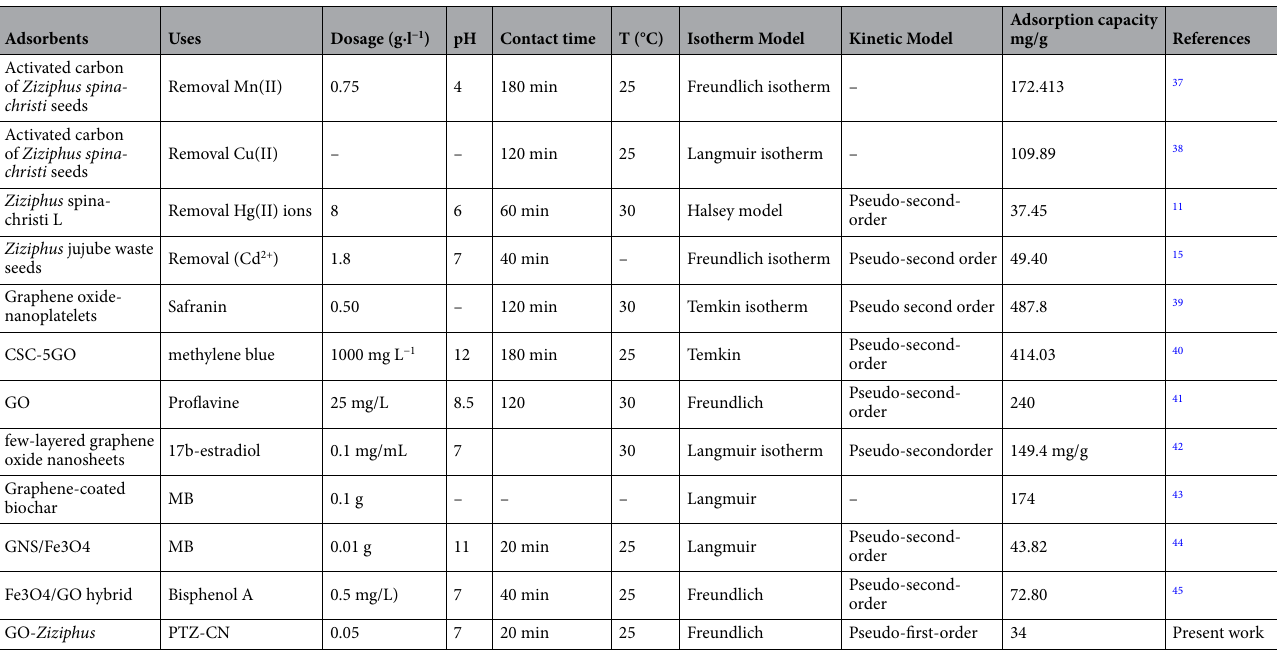
Table 3. Comparison of monolayer adsorption capacity of different carbonaceous materials as adsorbents of pollutants with characteristics similar to those used in graphene